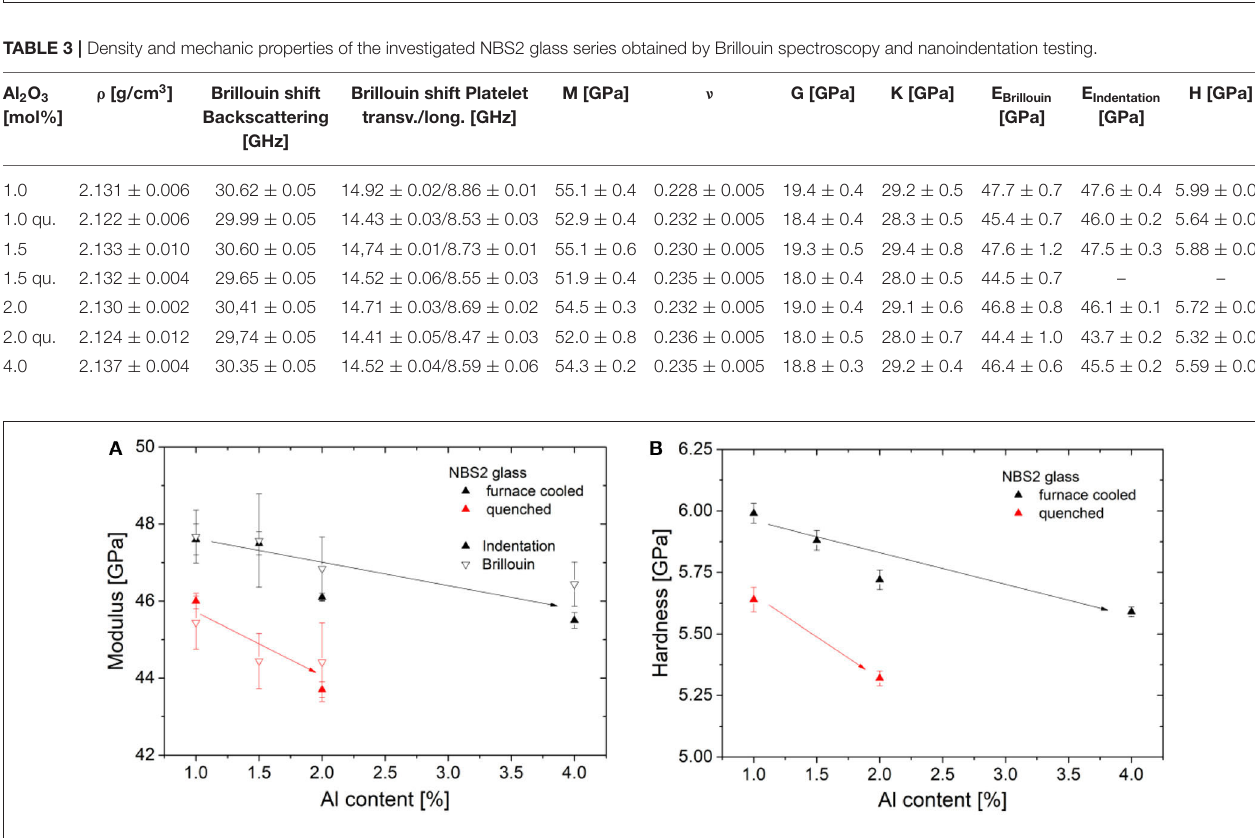
FIGURE 5 | (A) Young’s modulus and (B) Hardness from nanoindentation testing (solid symbols). An estimate of Young’s modulus from Brillouin spectroscopy is shown as open symbols. The thermal history, furnace cooled or quenched, is indicated by black or red color,